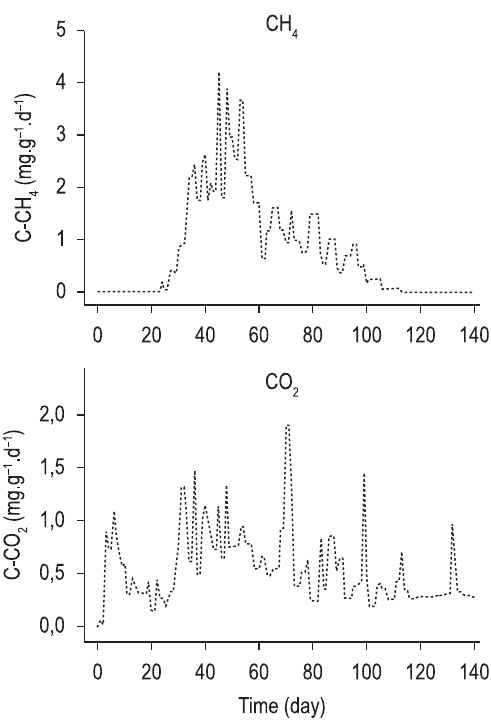
Figure 1. Variations of CH anaerobic decomposition of Oxycaryum cubense (at 20